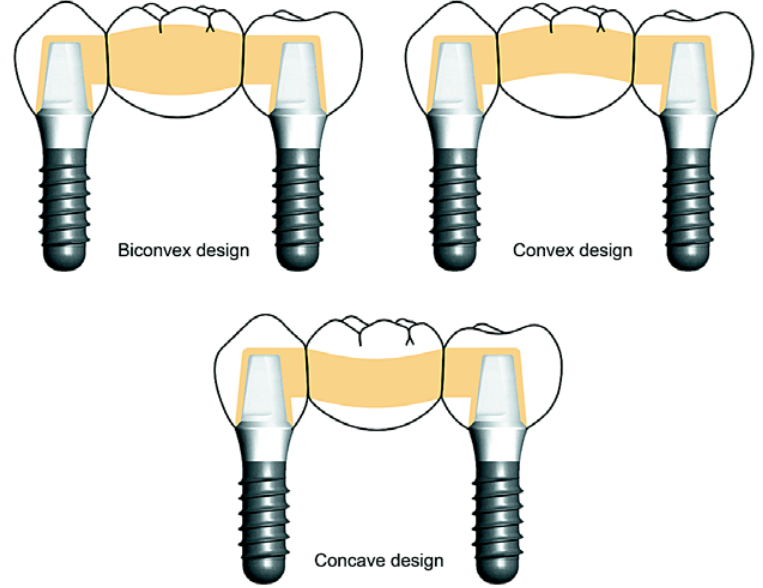
FIGURE 1- Pontic